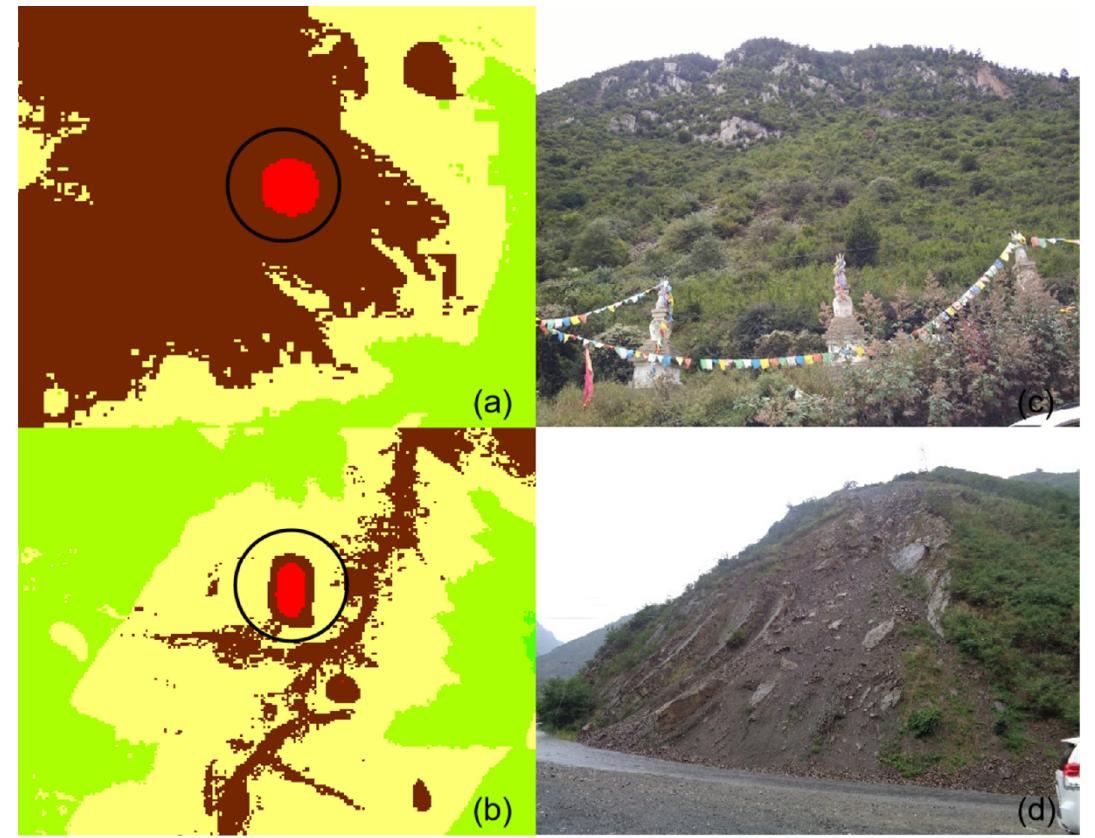
Figure 14. Earthquake-induced landslide events in Jiuzhaigou were documented through photo- graphs; for site location and LSM, see Figure 13. On the left is an enlarged LSM (Figure 13) for each site: ( a ) YG145 landslide in Zhangzha, ( b ) YG159 landslide in the Heye moutain. On the right, ( c ) and ( d ) are photo records of the selected EIL events (2018).